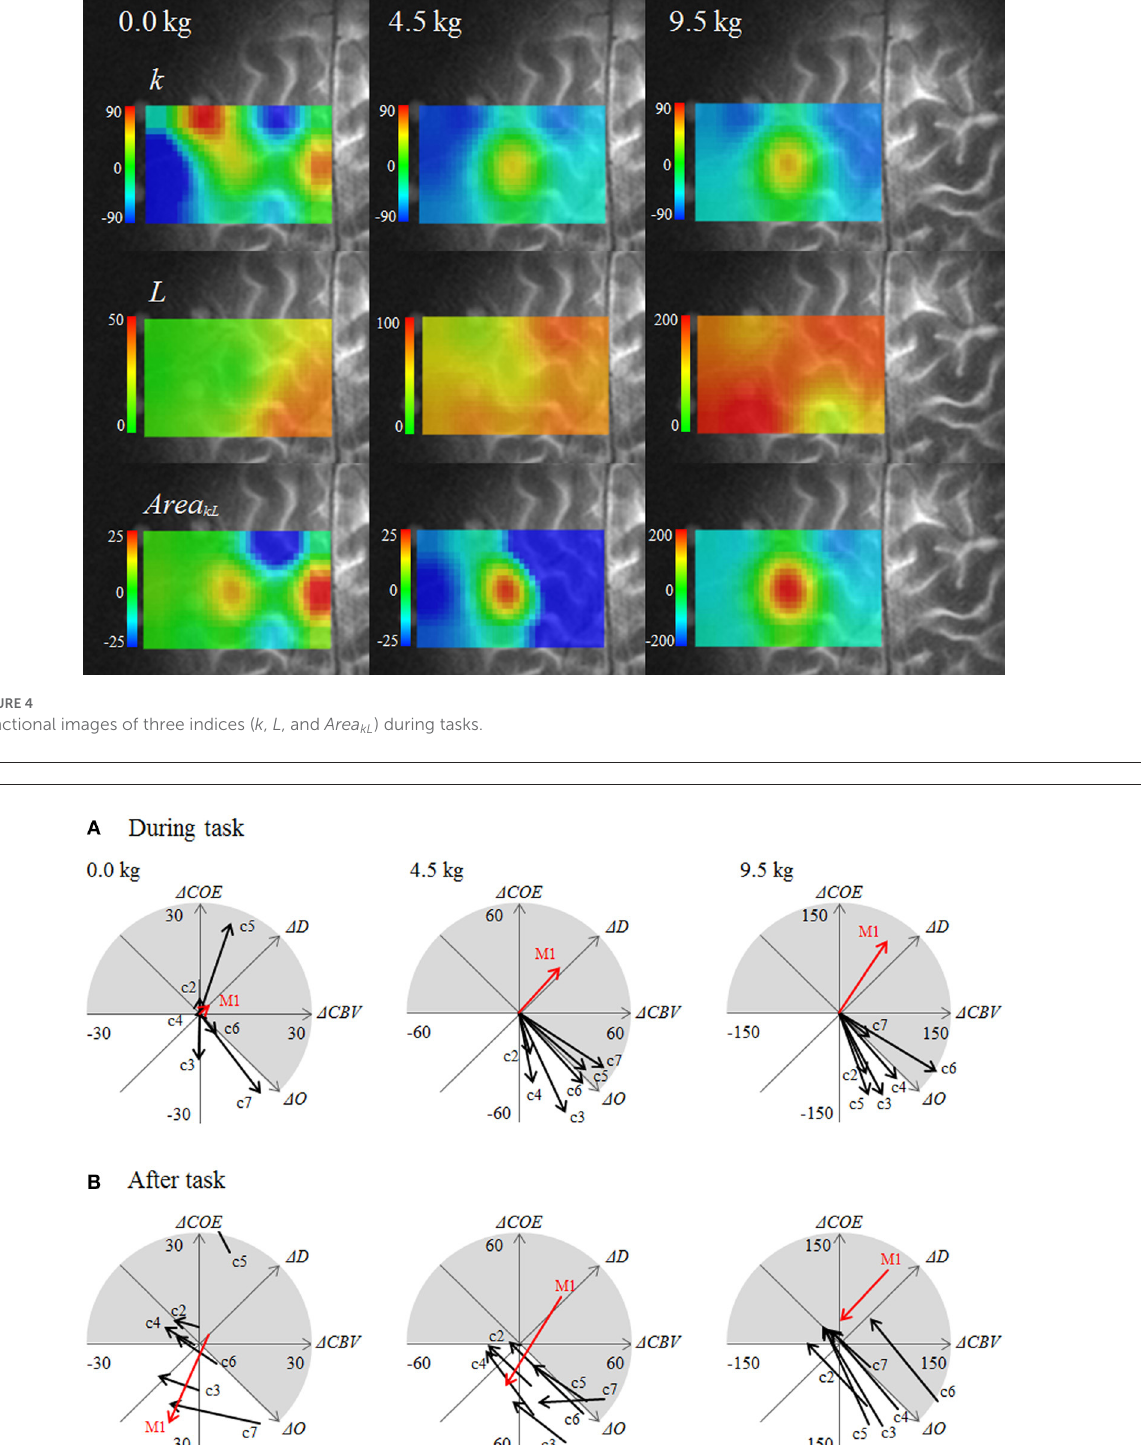
FIGURE5 (A) Addition vectors during a task (0–36s) and (B) after the task (36–72s). c2 through c7 are the numbers of channels in the area surrounding the left M1, as shown in Figure